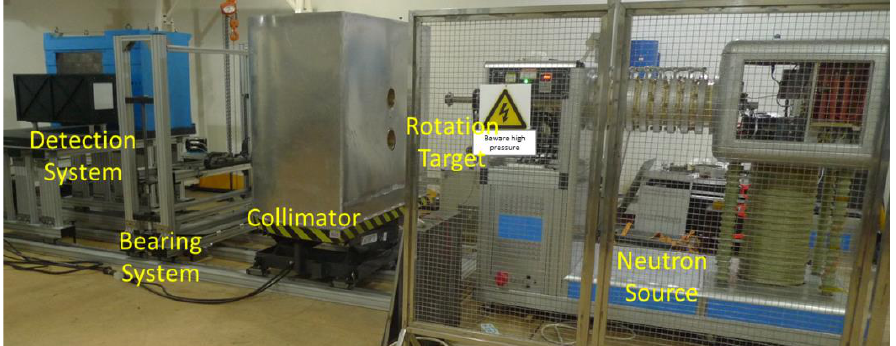
Figure 2. Picture of the fast neutron scanning imaging system.